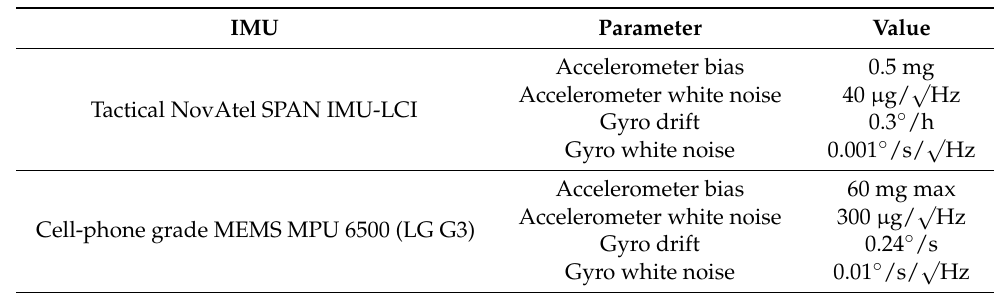
Figure 3. Data collection setup. Table 1. IMU